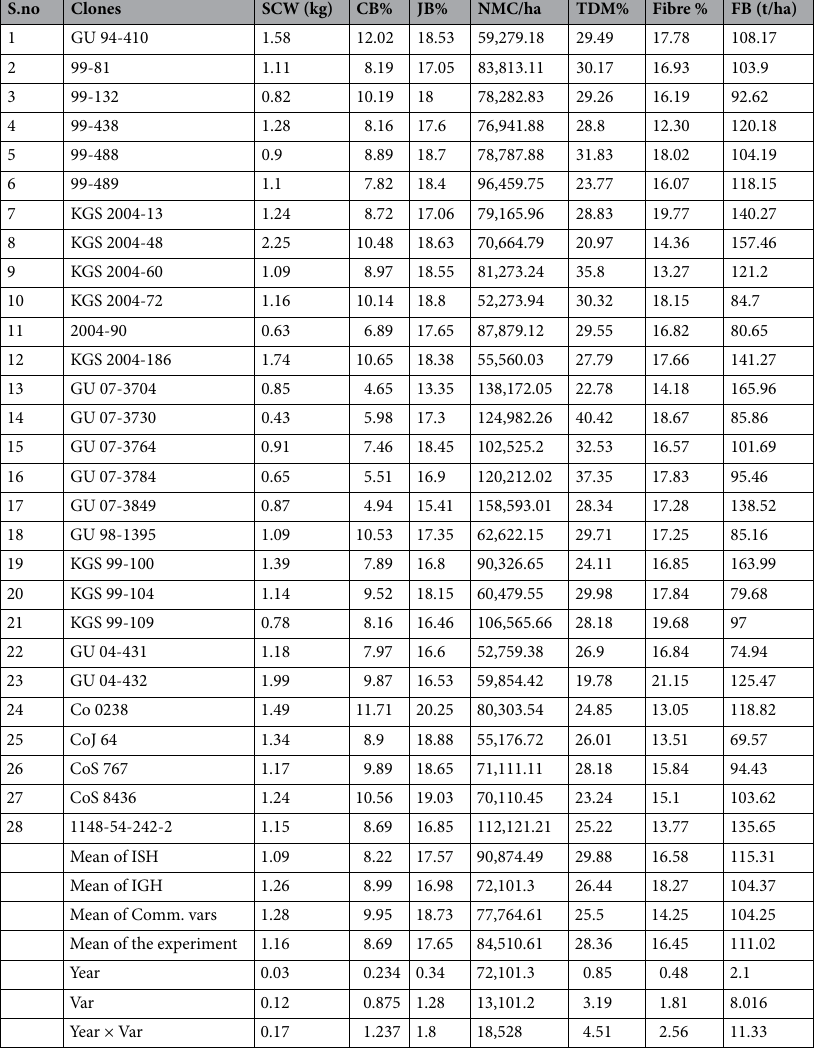
Comm. vars commercial